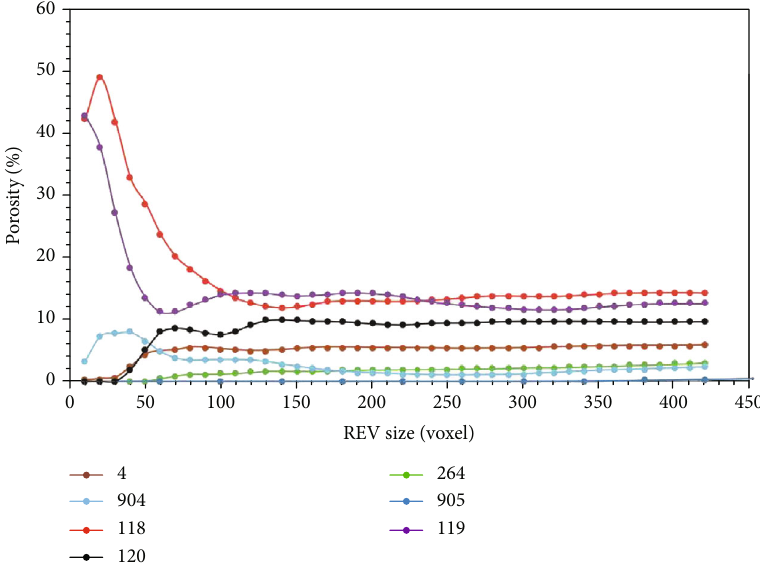
Figure 9: REV calculation with the coordinate from the center of the 3D